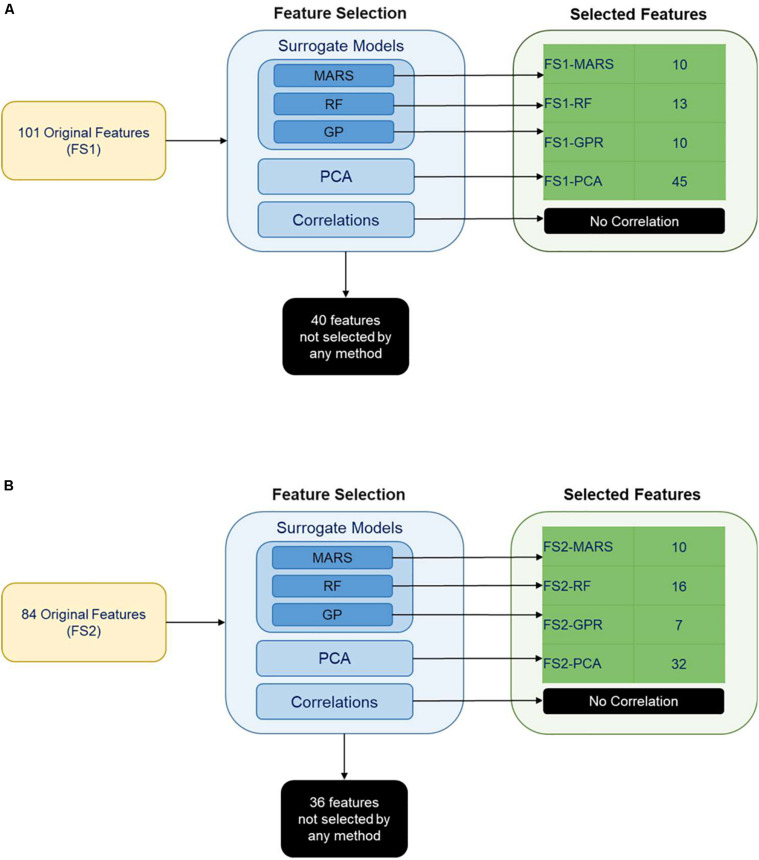
Feature selection results for features selected from (A) feature set 1 and (B) feature set 2. MARS (Multi-adaptive regression splines), RF (Random Forest), GPR (Gaussian process regression) were the surrogate models implemented for the selection of the features that have a significant impact on classification. The other feature selection methods were PCA (Principal component analysis) and correlations between the variables.